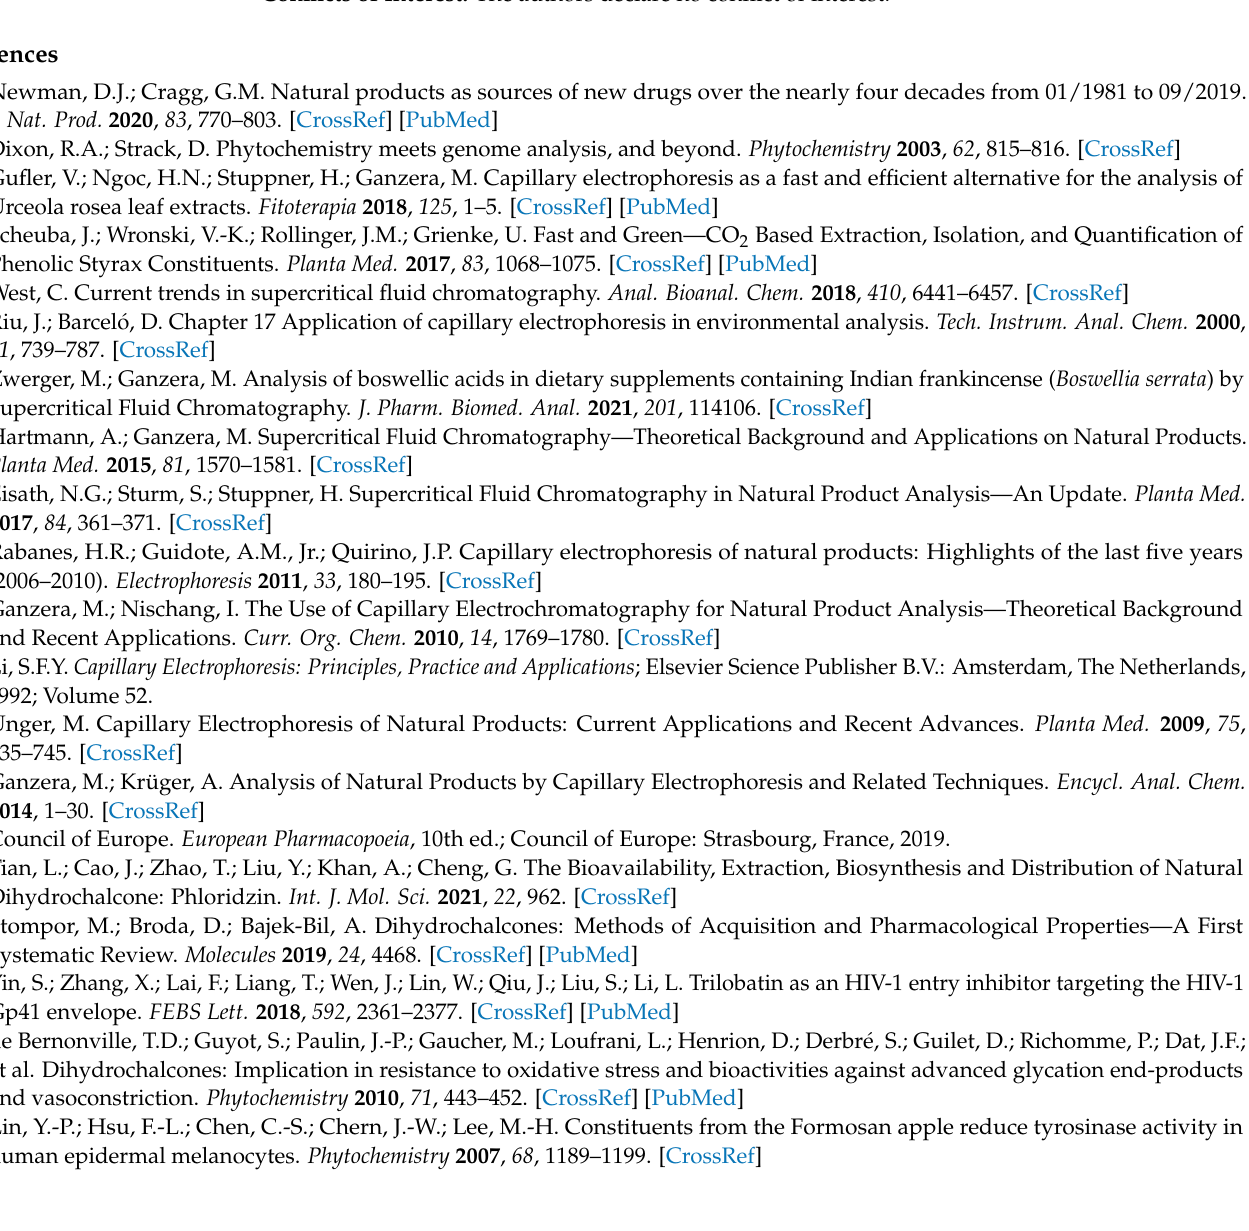
symmetry of the target analytes at different voltages, Figure S10: Resolution of the target analytes at different temperatures, Figure S11: Resolution of the target analytes using different organic additives, Figure S12: UV spectra of the five DHCs in comparison, Figure S13: SFC chromatograms of the analyzed samples, Figure S14: CE electropherograms of the analyzed samples, Figure S15: Statistical method comparison using a Bland–Altmann plot, Table S1: Stationary phases evaluated during this study, Table S2: Available information on the samples used in this